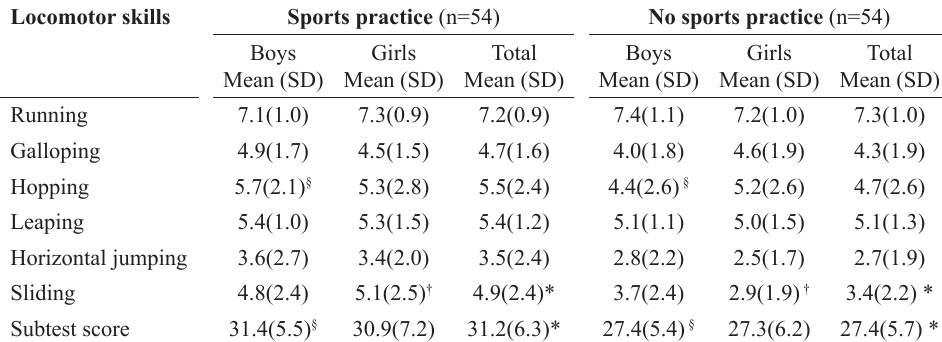
2. Mean and standard deviation (SD) from preschoolers boys’ and girls’ locomotor skills performances in the sports practice (SP) and no sports practice (NSP)